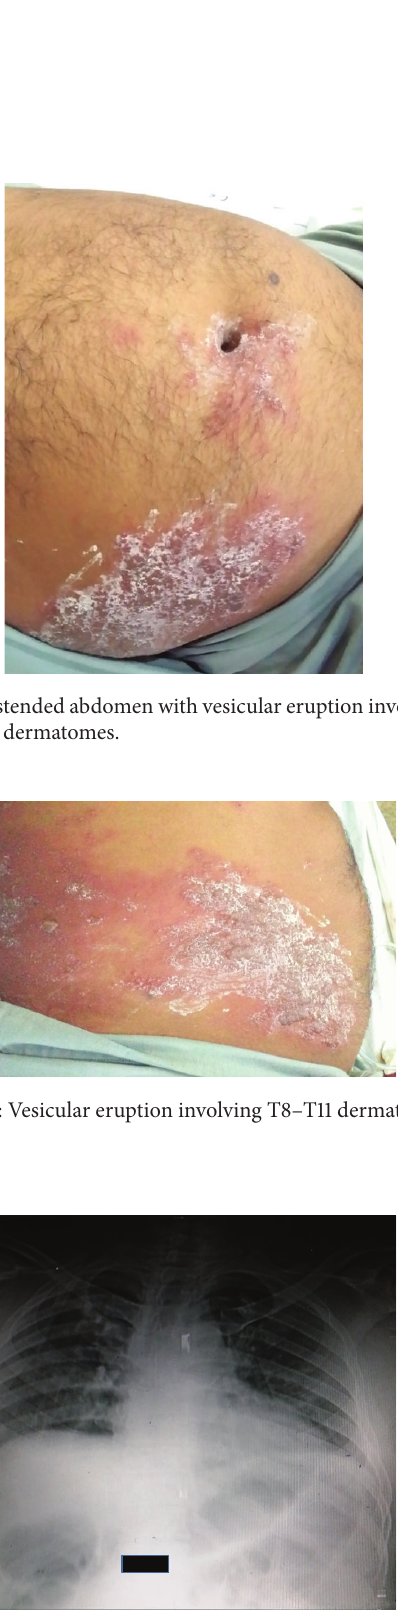
Figure 3: AXR: generalized distention of large bowel.